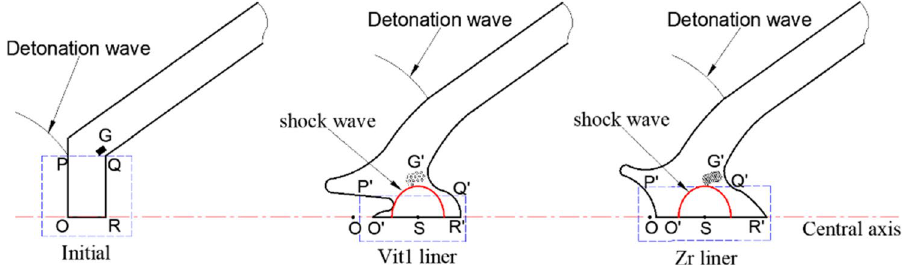
Figure 18. Schematic of the deformation of the two material liners.